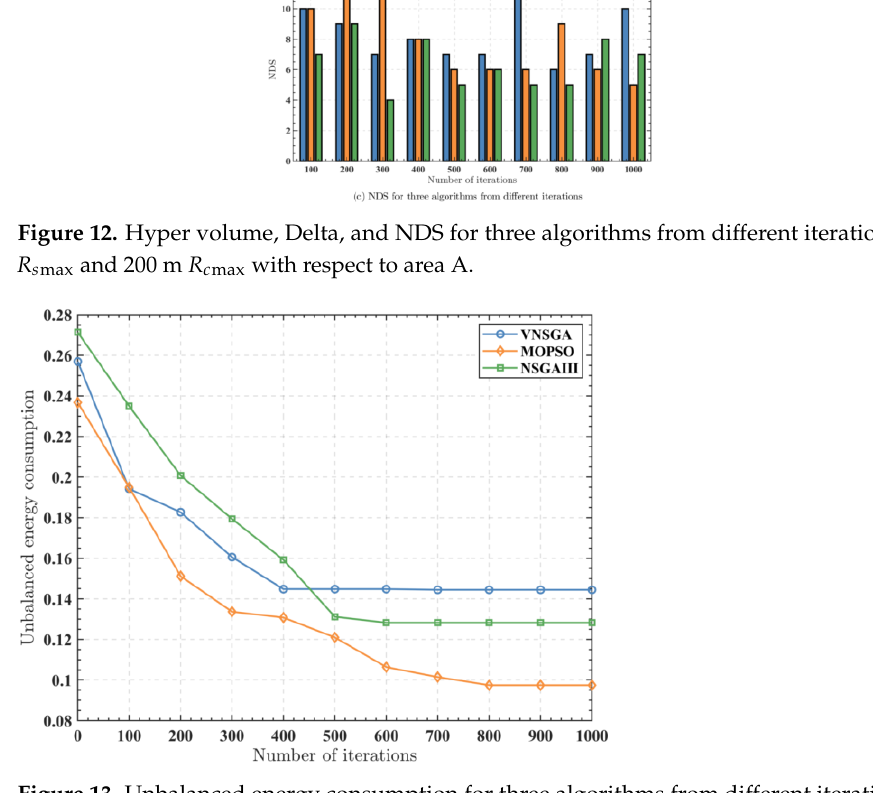
Figure 13. Unbalanced energy consumption for three algorithms from different iterations for 50 m R s max and 100 m R c max with respect to area A.